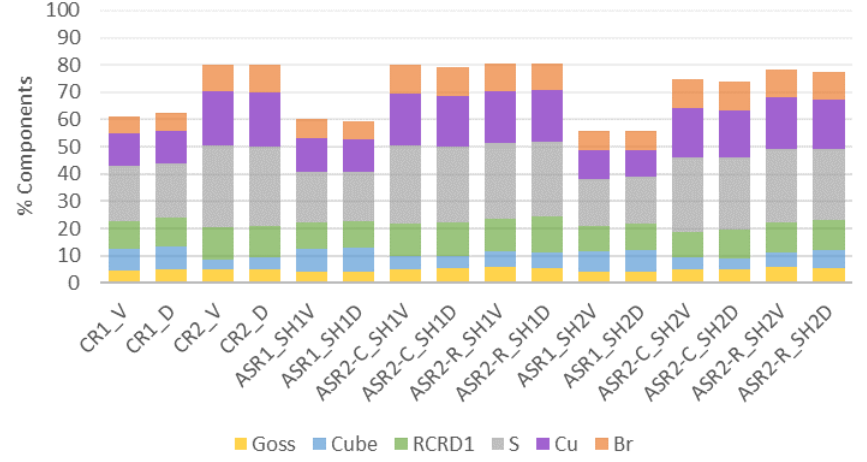
Figure 16. VPSC texture rolling components for two-pass sequences with 30% reduction per pass.